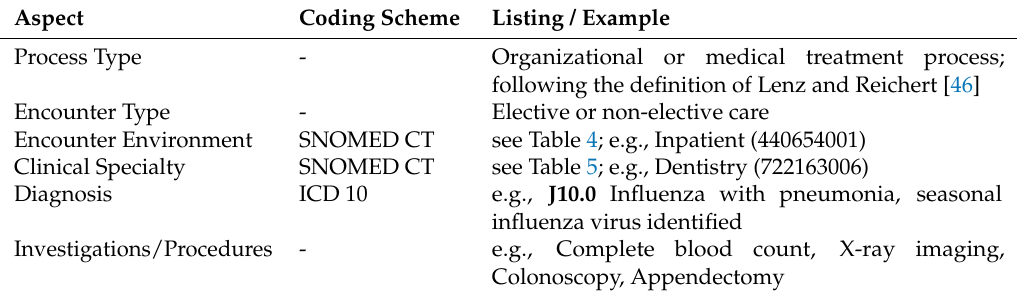
Table A2. Clinical aspects of the mined healthcare process.